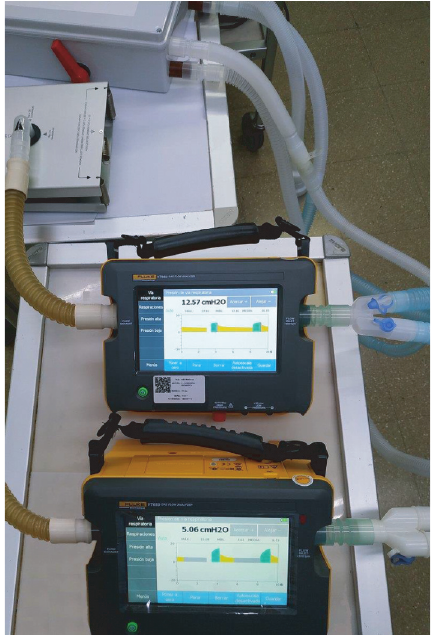
Figure 2: The experimental model: a ventilator connected through the DuplicAR Ⓡ device to two gas flow analyzers and their re- spective test lungs.